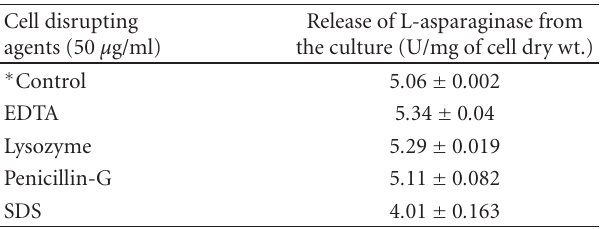
Table 5: E ff ect of cell-disrupting agents on the release of L- asparaginase from 72 h old culture of Nocardia